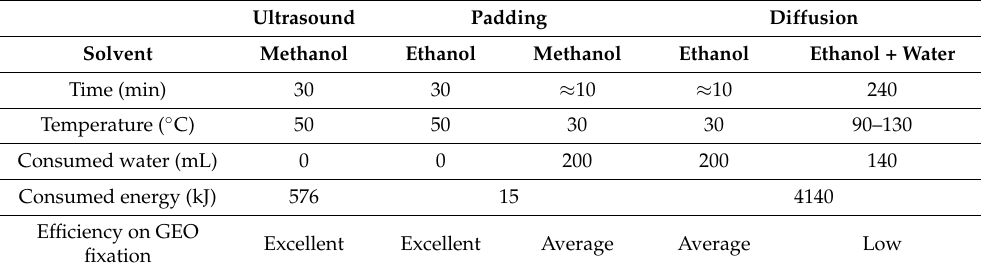
Table 1. Main parameters of different treatments methods for both PET and CO